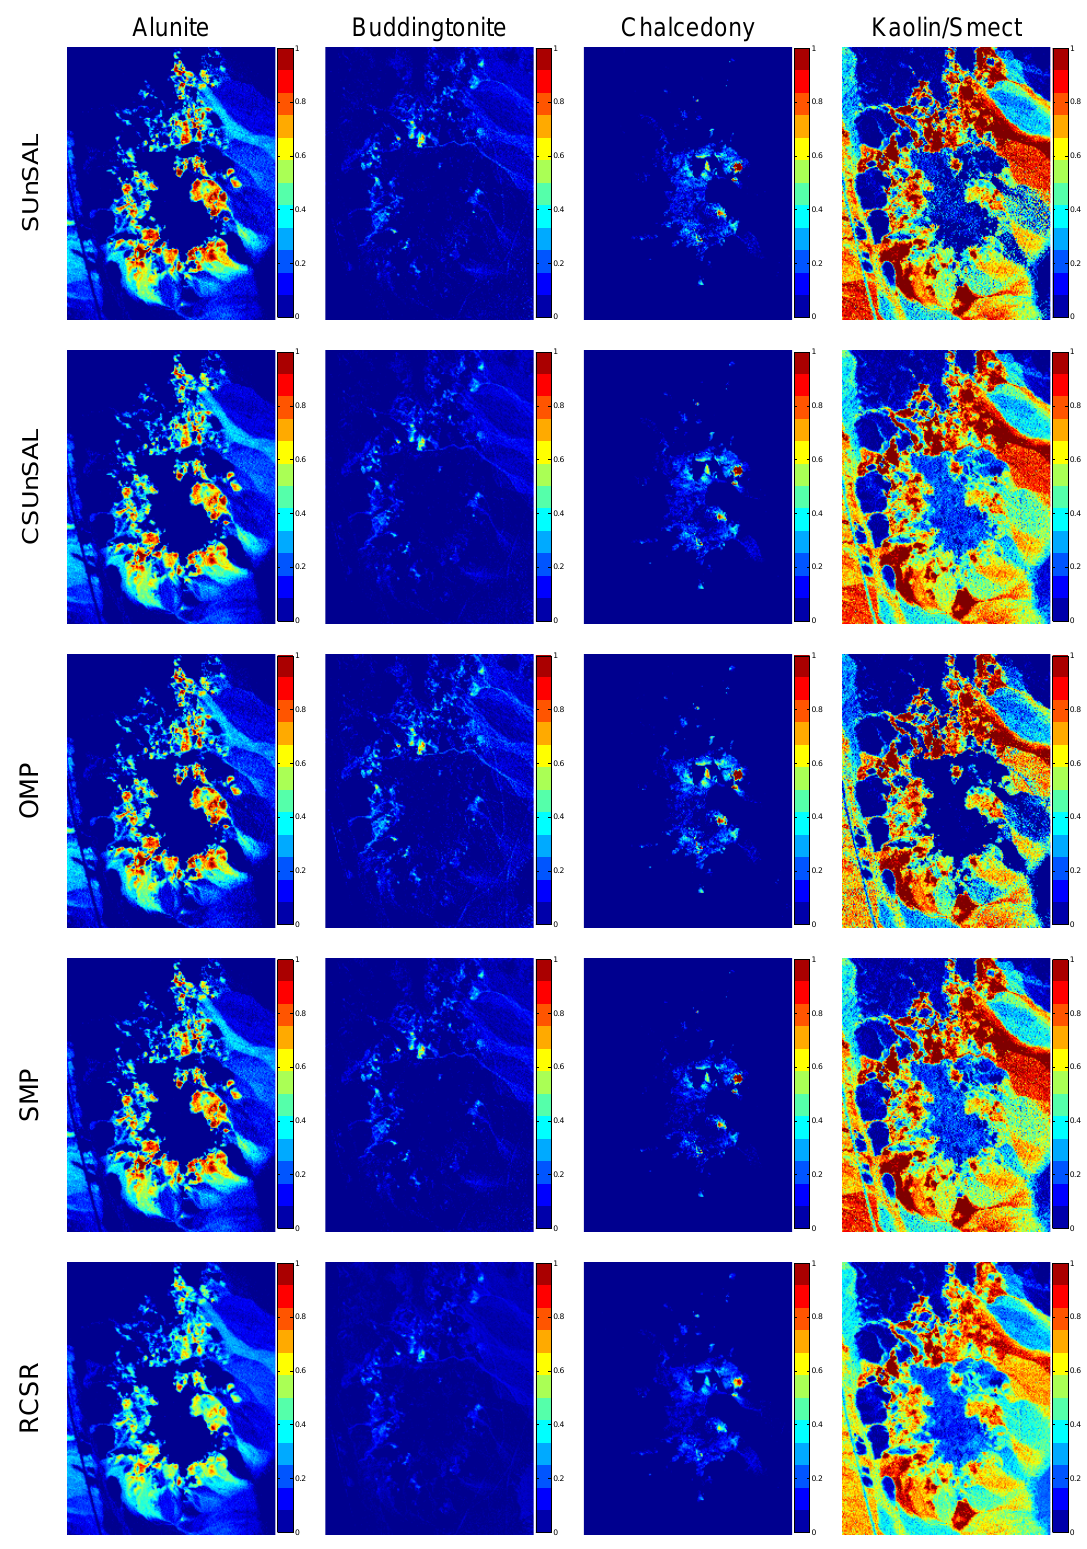
Figure 10. Fractional abundance maps estimated by different unmixing methods using the subimage of the AVIRIS Cuprite